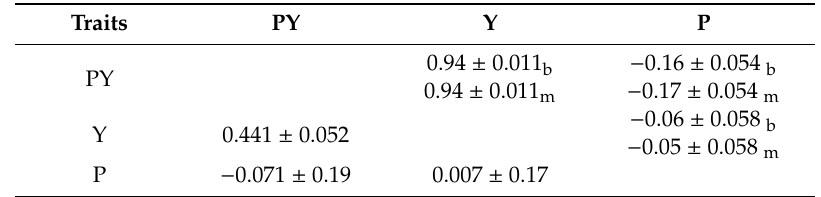
Table 3. Genetic (above diagonal) and phenotypic correlations (below diagonal) for PY, Y and P traits in Murciano-Granadina